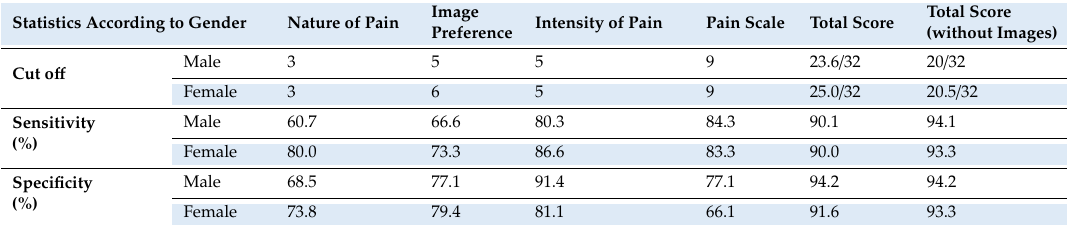
Figure 3. ROC curves according to gender. The AUC male group: AUC Total score = 0.977; AUC Total score (no images) = 0.979; AUC Intensity = 0.881; AUC Pain scale = 0.852; AUC Image preference = 0.751; AUC Nature of pain = 0.640. The AUC female group: AUC Total score = 0.948; AUC Total score (no images) = 0.975; AUC Intensity = 0.838; AUC Pain scale = 0.795; AUC Image preference = 0.726; AUC Nature of pain = 0.761. The area under the ROC curve is significantly greater than 0.5 ( p < 0.001).